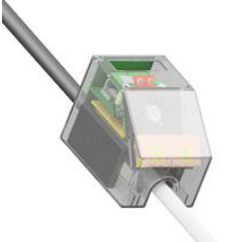
Figure 17. Mockup of the integrated INSPEX device.